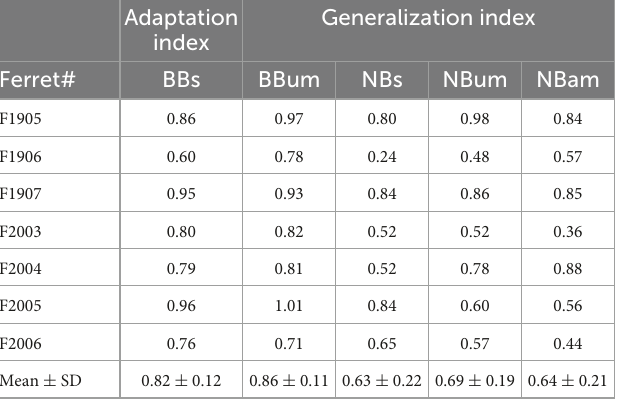
TABLE 6 Adaptation and generalization